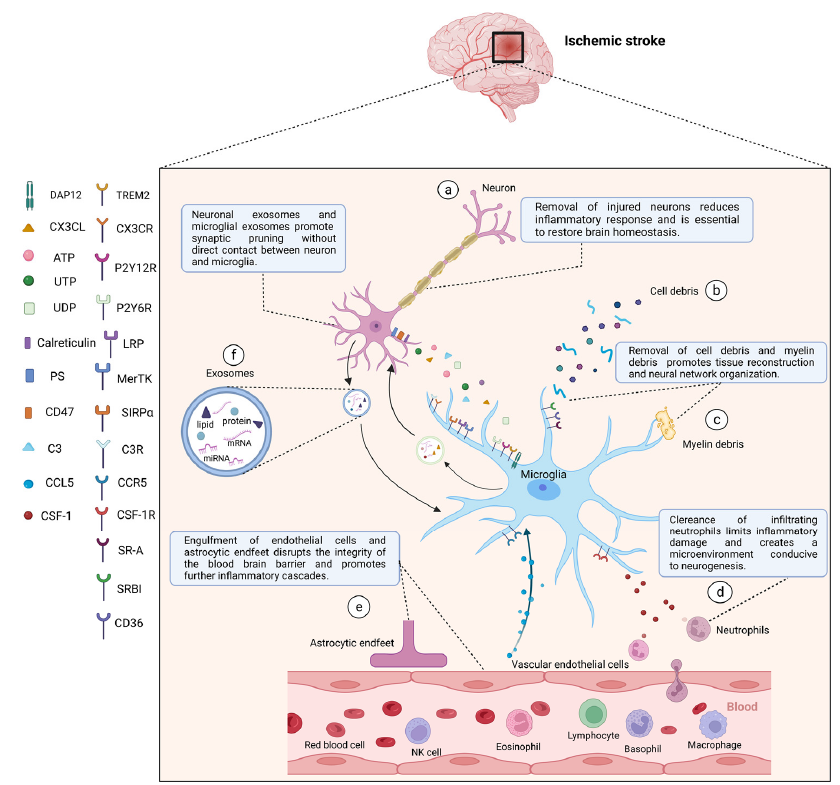
Figure 3. After stroke, activated microglia mediate phagocytosis in the central nervous system through a combination of ligands expressed by target cells and corresponding receptors in microglia. After stroke, activated microglia can directly phagocytose damaged or dead neurons ( a ), cell debris ( b ), myelin debris ( c ), and peripheral neutrophils ( d ) to reduce inflammatory responses, create a microenvironment for tissue repair, and restore brain homeostasis. Microglia can also phagocytose vascular endothelial cells and astrocytic endfeet ( e ) to damage the integrity of the blood-brain barrier and exacerbate the inflammatory development. In addition, neuronal exosomes and microglial exosomes can promote synaptic pruning ( f ). ( a ) Injured neurons can express “Find me” signals, including CX3CL, ATP, UTP, and UDP, recognized by corresponding microglial receptors including CX3CR, P2Y12R, P2Y6R, and “eat me” signals including PS, calreticulin, C3 recognized by LRP, MerTK, and C3R respectively. “Do not eat me” signal (CD47) can be downregulated, and its receptor is SIRP α . ( d ) Neutrophils release CSF-1, which is recognized by CSF-1R in microglia. ( e ) Vascular endothelial cells secrete CCL5, which binds to CCR5 in microglia to play a protective role in main- taining the integrity of the blood-brain barrier. Other microglial surface receptors, including TREM2, SR-A, SR-BI, CD36, are involved in the clearance of apoptotic cells as well as cell and myelin debris. CX3CL, C-X3-C motif chemokine ligand; CX3CR, C-X3-C motif chemokine receptor; ATP, adenosine triphosphate; UTP, uridine triphosphate; UDP, uridine diphosphate; P2Y12R, P2Y12 receptor; P2Y6R, P2Y6 receptor; PS, phosphatidylserine; MerTK, c-mer tyrosine kinase; C3, complement 3; C3R, C3 receptor; LRP, low-density lipoprotein receptor-associated protein; SIRP α , signal regulatory protein α ; CSF-1, colony-stimulating factor-1; CSF-1R, CSF-1 receptor; CCL5, C-C motif chemokine ligand 5; CCR5, C-C motif chemokine receptor 5; TREM2, triggering receptor expressed on myeloid cells 2; DAP12, DNAX activation protein 12; SR-A, scavenger receptor A; SR-BI, scavenger receptor class B type I. Created with